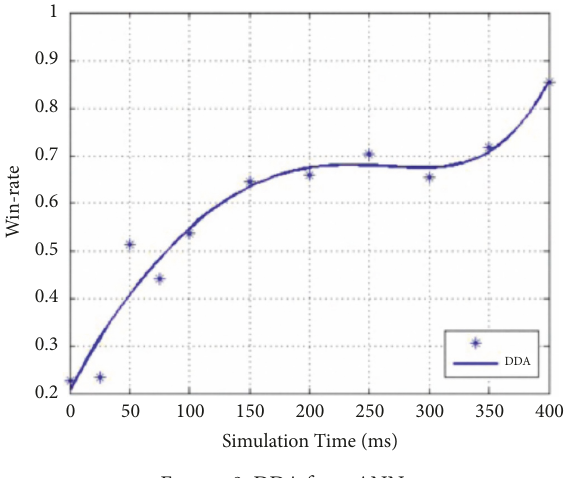
Figure 8: DDA from UST. Figure 9: DDA from